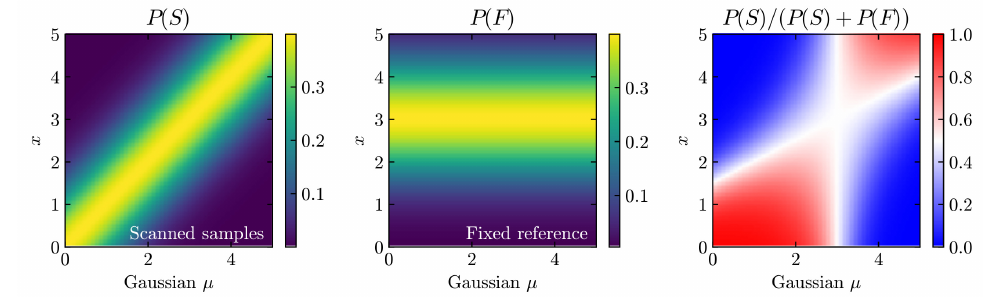
Figure 15. DCTR works by using a classifier to approximate the likelihood ratio. In this example, we use Gaussian distributions to show the procedure using exact likelihood ratios. The left panel shows the probability density for a sample of data in which the mean of the Gaussian can take any value between 0 and 5; this is referred to as the scanned sample. The middle panel shows the probability density for the fixed sample, where the mean is always set to 3 and µ has no meaning. The right panel shows what the probability is for a point in the µ, x parameter space to come from the scanned sample as opposed to the fixed sample, which is the result of an ideal